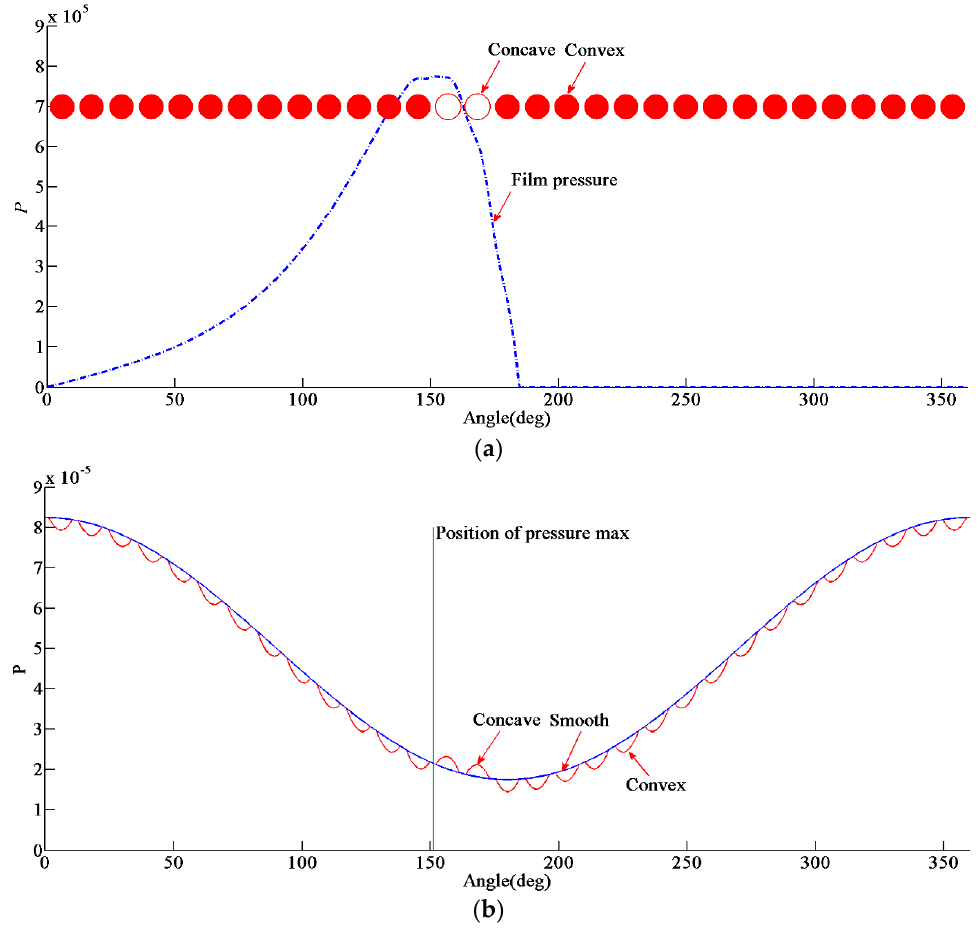
Figure 6. Distribution of concave-convex composite spherical texture: ( a ) circumferential film pressure distribution, ( b ) circumferential film thickness distribution diagram.